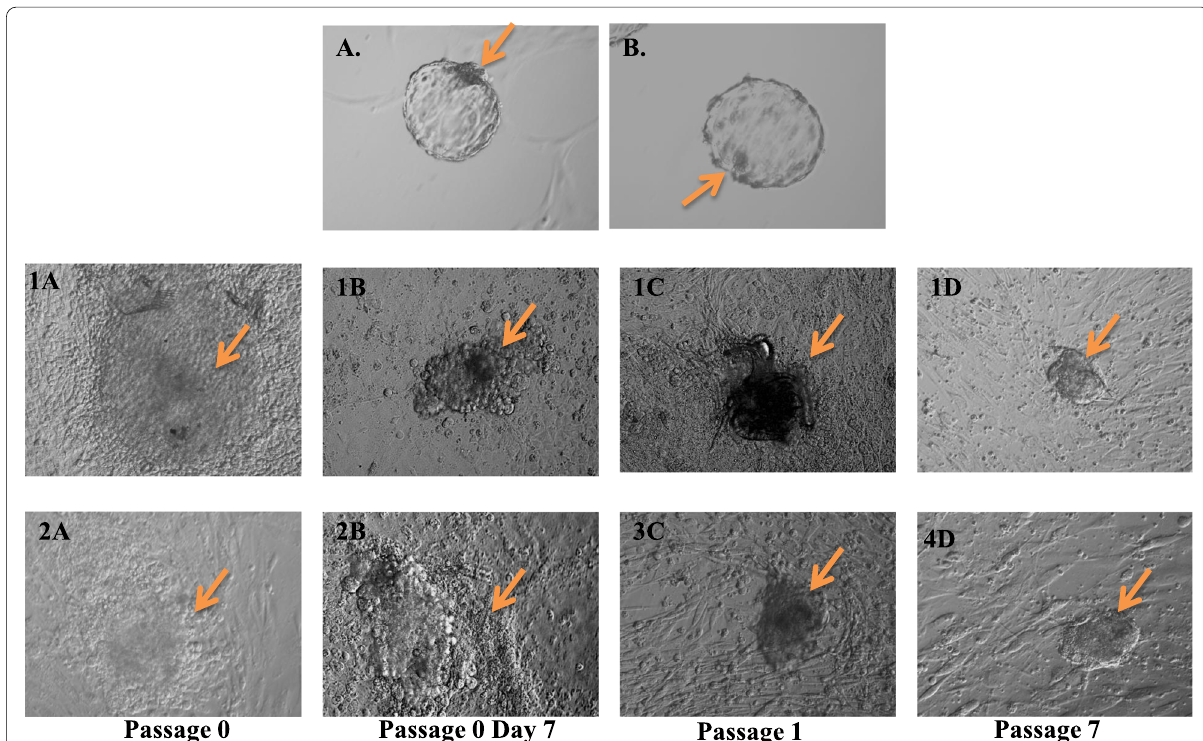
Fig. 5 Isolation and culture of buffalo embryonic stem cells. A , B In vitro produced hatched blastocysts; inner cell masses mechanically isolated from hatched blastocysts; and seeded on buffalo fetal fibroblast feeder layer ( 1A , 2A ) and putative buffalo embryonic stem cells were formed on 7th day. These putative embryonic stem (ES) cells colonies were passaged 7 times (1D, 4D). The buESCs were maintained in ESC medium which contained BuLIF in the concentration of 40 ng/ml. The arrow represents the undifferentiated cells. Magnification